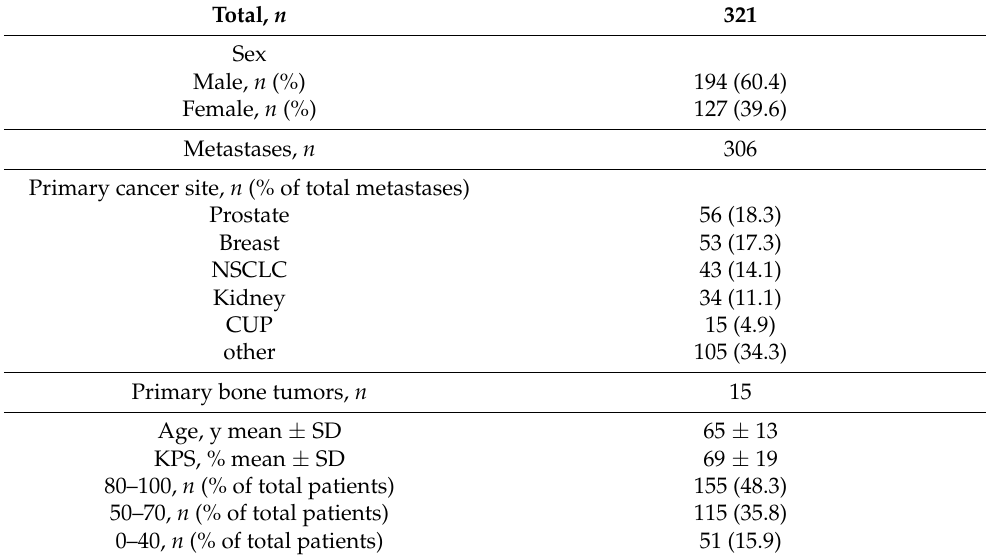
Table 1. Demographic details. Baseline characteristics of patients with spinal metastases and primary bone tumors of the spine are depicted. CUP = cancer of unknown primary, KPS = Karnofsky performance status scale, n = number, NSCLC = non-small-cell lung cancer, SD = standard deviation, y = years.